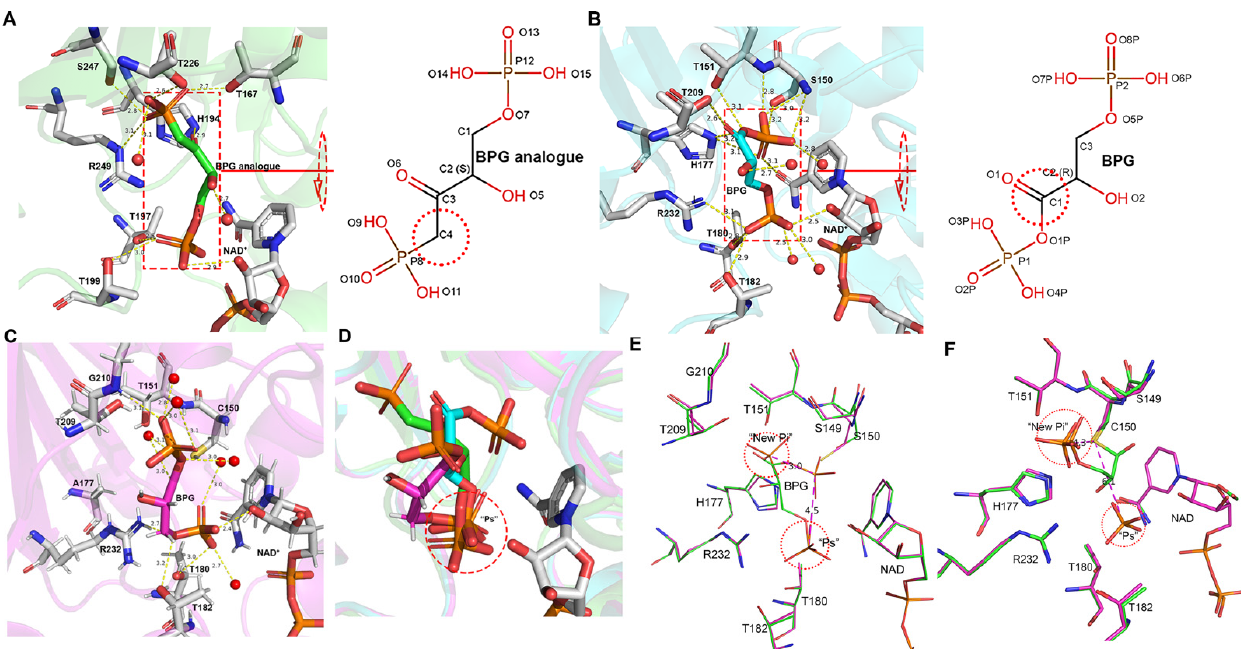
Figure 5. Structure of Ec GAPDH1-binding BPG. ( A – C ) The network of interactions that stabilize the BPG analog and BPG. ( A ) BPG analog of the A subunit of Trypanosoma cruzi GAPDH complexed with an analog of 1,3-bisphospho-d-glyceric acid ( Tc GAPDH, PDB code 1QXS, green). The left panel of A is a 2-D BPG analog. ( B ) BPG of the O subunit of C150S.NAD.BPG (7C5R, Cyan). The left panel of B is 2-D BPG. ( C ) P subunit of H177A.NAD.BPG (7C5Q, Magenta). ( D ) Superimposition of the above structure. ( E ) Superposition of phosphate, coenzyme, and amino acids interacting with phosphate from the R subunit of WT.NAD.PO 4 (magenta) with the corresponding amino acids, coenzymes, and BPG of the O subunit of C150S.NAD.BPG (green). ( F ) Superposition coenzyme and amino acids interacting with the phosphate from the R subunit of WT.NAD.PO 4 with the corresponding amino acids, coenzymes, and G3P of the R subunit of the thioacyl intermediate.